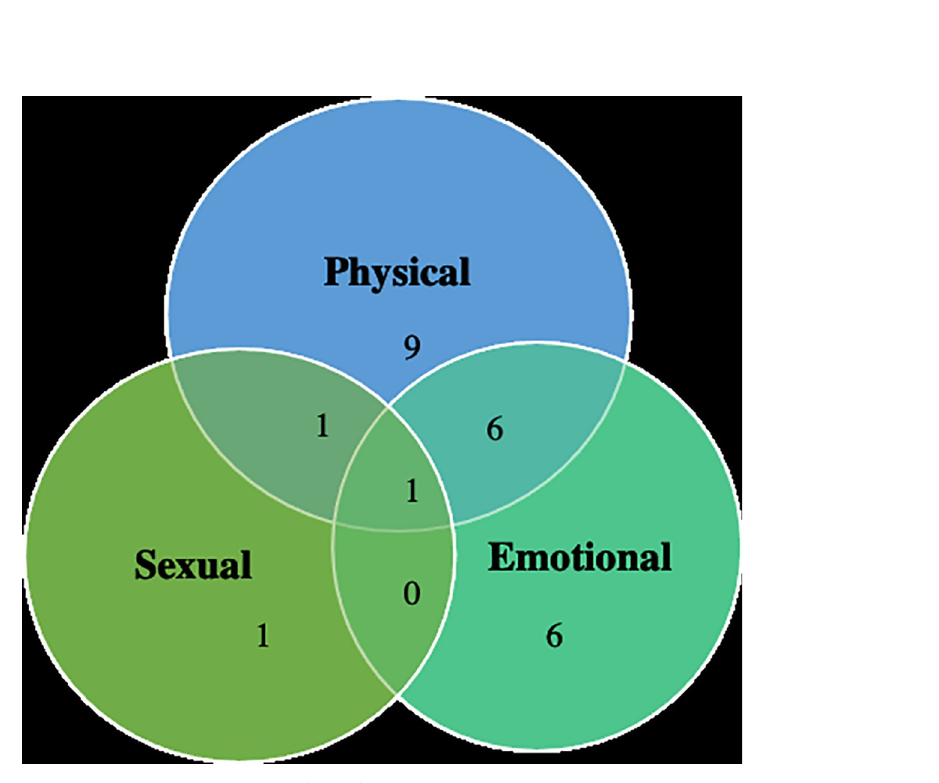
Fig 1. Forms of violence reported (n =